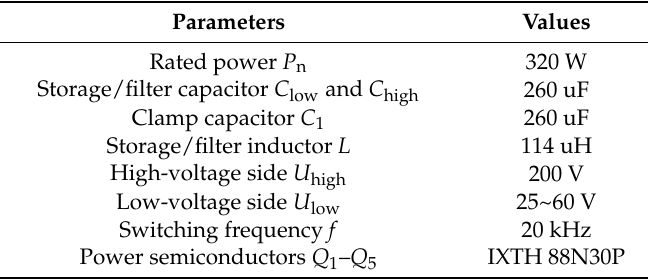
Table 1. Experiment